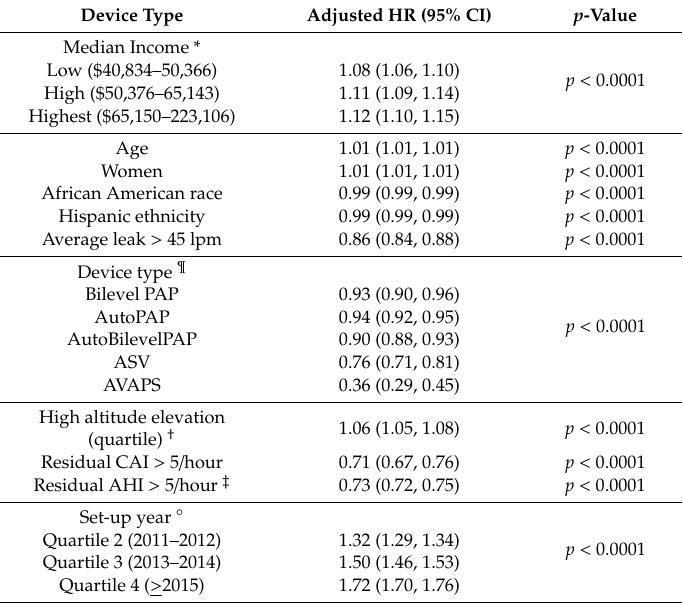
Table 6. Cox proportional hazards for adherence to PAP therapy.